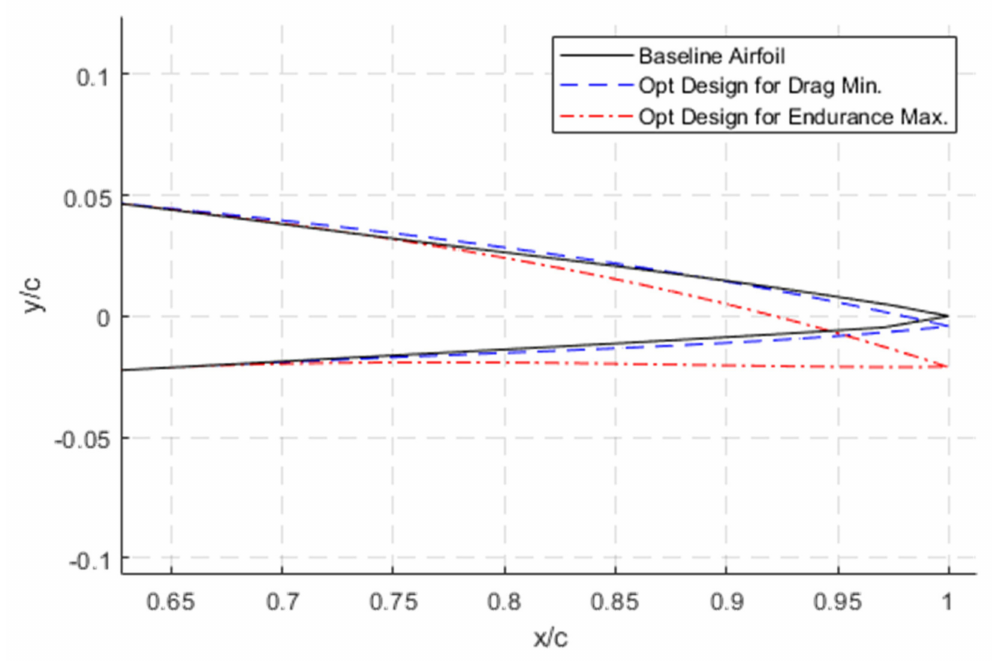
Figure 25. Comparison of MTE airfoil shapes based on different performance objectives. The contour plots of the velocity magnitude and of the turbulent kinetic energy are visualized for the baseline airfoil and for the airfoils optimized by the Transition ( γ − Re θ ) SST turbulence model in Figure 26. These contour plots reveal that for a given MTE deflection, larger TE separation regions are found at 4 ◦ angles of attack than at 10 ◦ angles of attack. Similarly, the vertex of turbulent kinetic energy (TKE) originating from the MTE at an angle of attack of 40 ◦ has more strength than the vertex an the angle of attack of 10 ◦